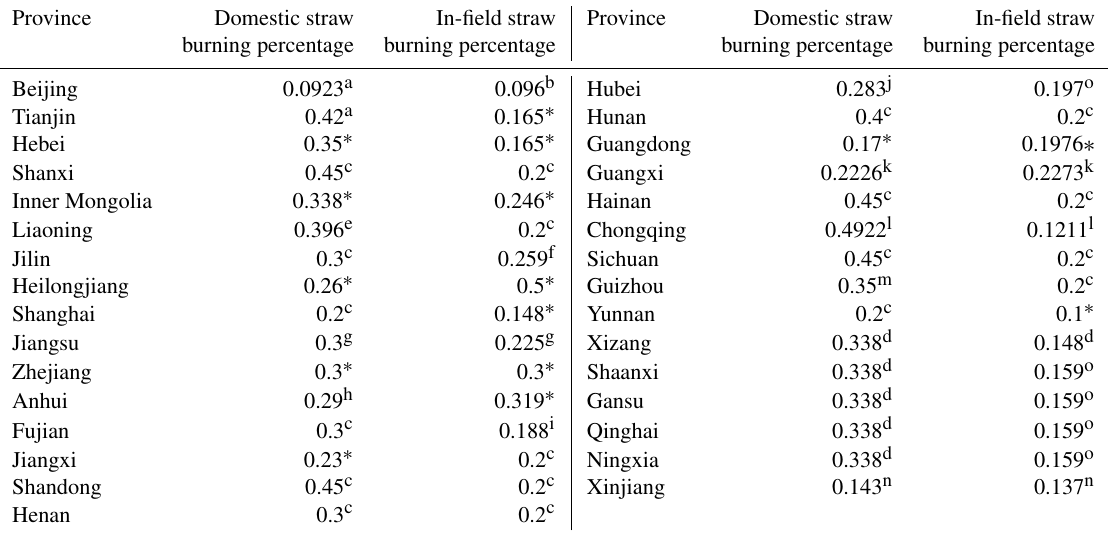
Table 2. Domestic and in-field straw burning percentage of each province. Province